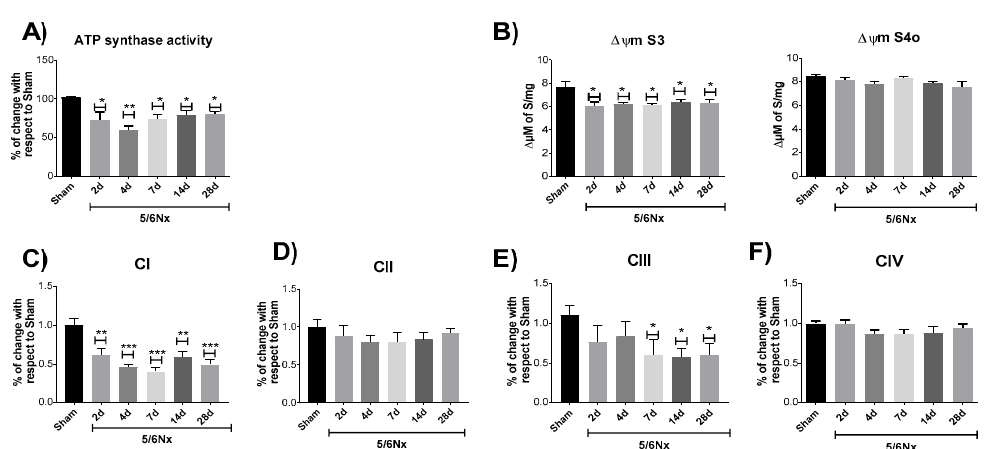
Figure 5. Changes in oxidative phosphorylation (OXPHOS) system elements and membrane potential ( ∆ ψ m). ( A ) ATP synthase activity. ( B ) Change in ∆ ψ m in state 3 (S3) and ∆ ψ m in state 4 induced by oligomycin (S4o). ( C ) Complex I (CI); ( D ) complex II (CII); ( E ) complex III (CIII); and ( F ) complex IV (IV). Data are mean ± SEM, n = 4–7. * p < 0.05, ** p < 0.01, and *** p < 0.001 vs. Sham, Dunnett test. d =